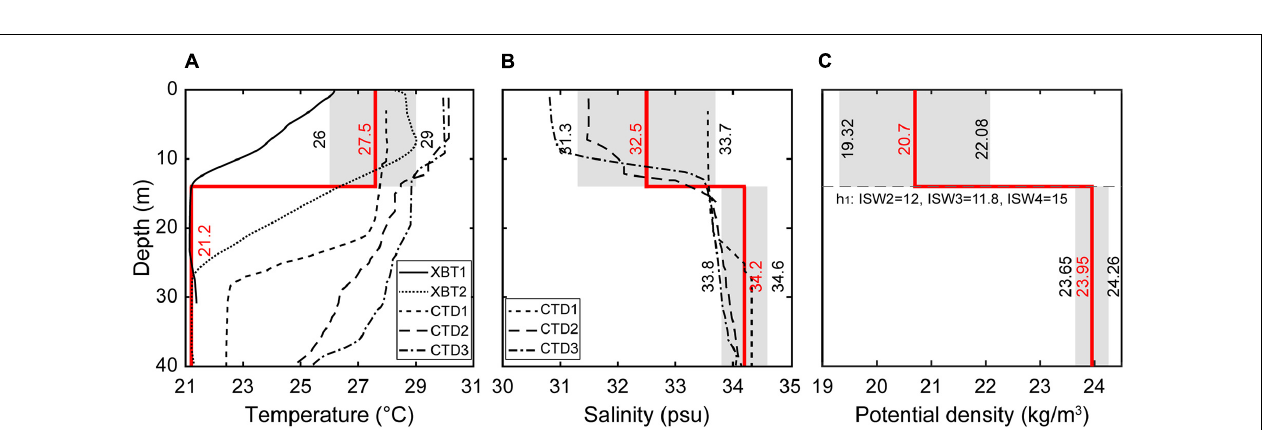
FIGURE 6 | Temperature profiles of the XBT and CTD stations (A) and salinity profiles of the CTD stations (B) . The CTD data were collected from July 27 to August 16, 2009 (modified by Chen et al., 2017). The gray filled shades indicate the possible ranges of the temperature (A) , salinity (B) , and potential density (C) of the upper layer and the lower layer in the study area according to the XBT2, CTD1–3, and ZHJ2 data, and the solid red lines represent the median values of the possible range. The locations of the XBT, CTD, and ZHJ2 stations are shown in Figure 1 .